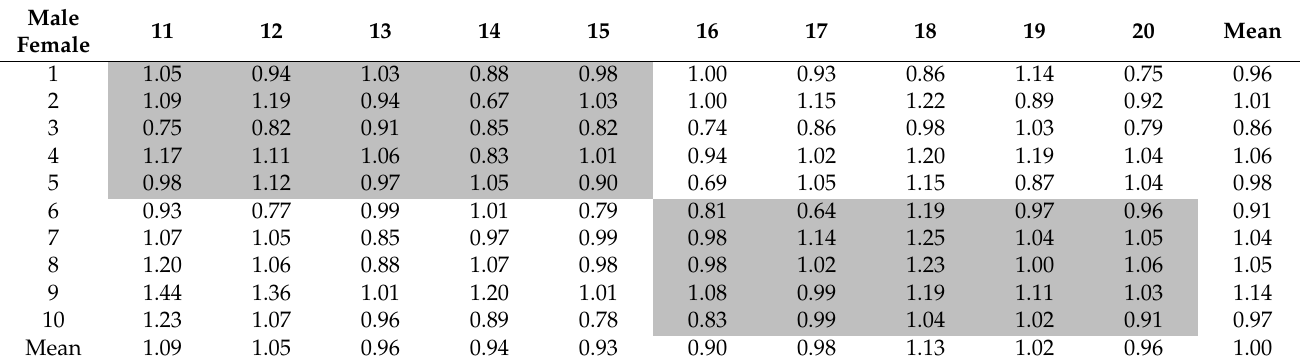
Table 5. Estimates of regression coefficients for annual height increment of 100 full-sib families planted at seven sites (sites 1–7). The regression coefficients of the N × N and E × E families are